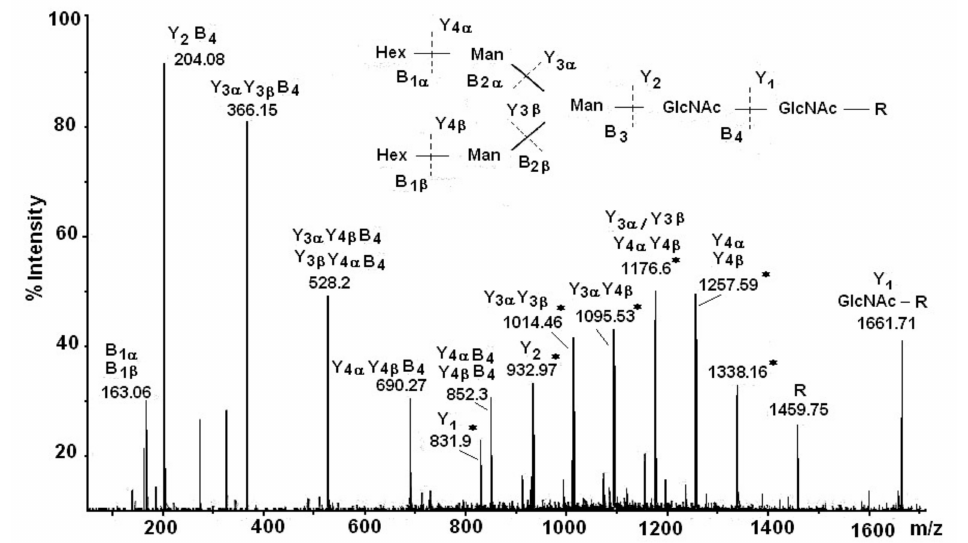
Figure 5. Nano-ESI- MS / MS analysis of the glycan G1, bound to glycopeptides, presented as an ion at m / z 1338.16 [M + 2H] 2 +